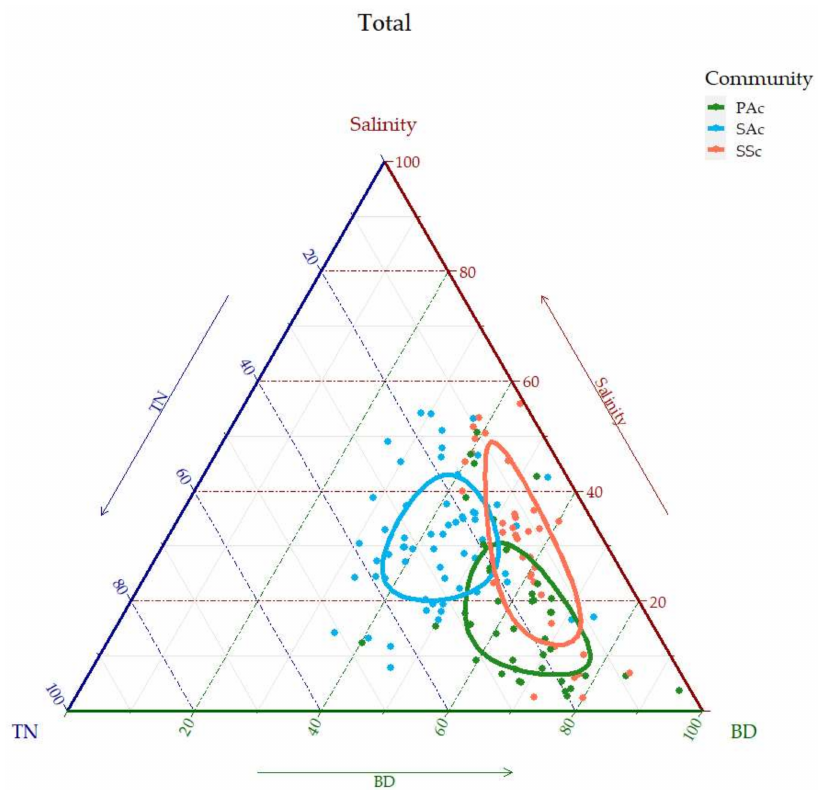
Figure 5. Ternary plots of community distribution. Different colors represent different communities. The three soil factor data were normalized, and the sum of the three equaled to one. Circles indicate 95% confidence